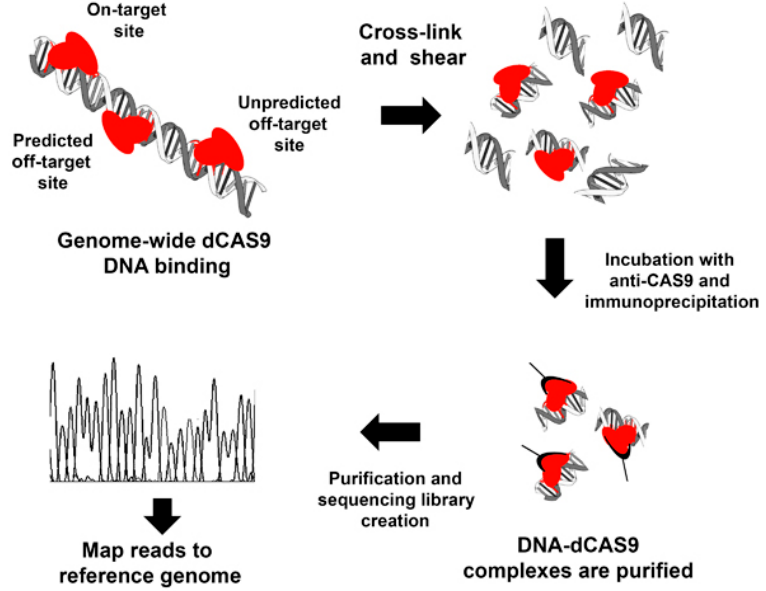
Figure 2. Off-target analysis by ChipSeq using dCas9. Endonuclease-defective Cas9 (dCas9) are transfected into the target cells. dCas9 remains stably bound to target sites due to the lack of endonuclease activity. Target cell DNA is extracted and sheared to obtain small DNA fragments. Some of these DNA fragments have bound dCas9 and can be purified using monoclonal Cas9 antibodies. The DNA fragments are further purified to construct a library of DNA sequences that bind to that particular Cas9-gRNA combination in the cell analyzed.